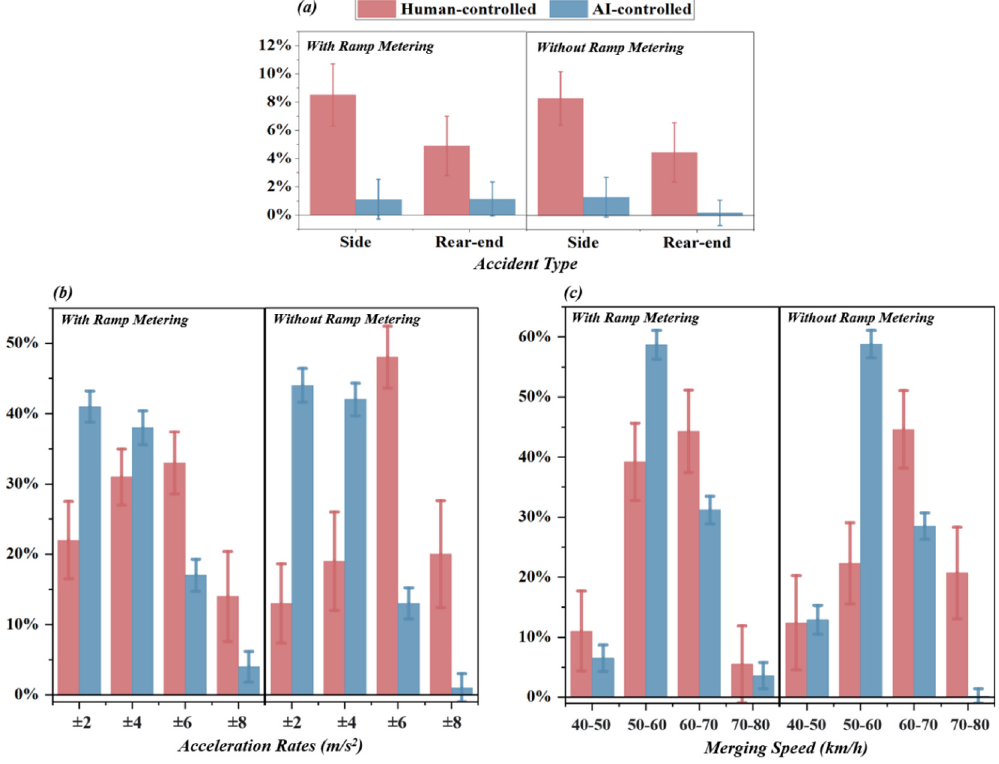
Figure 8 Comparison between the developed AV and human-controlled vehicle in relation